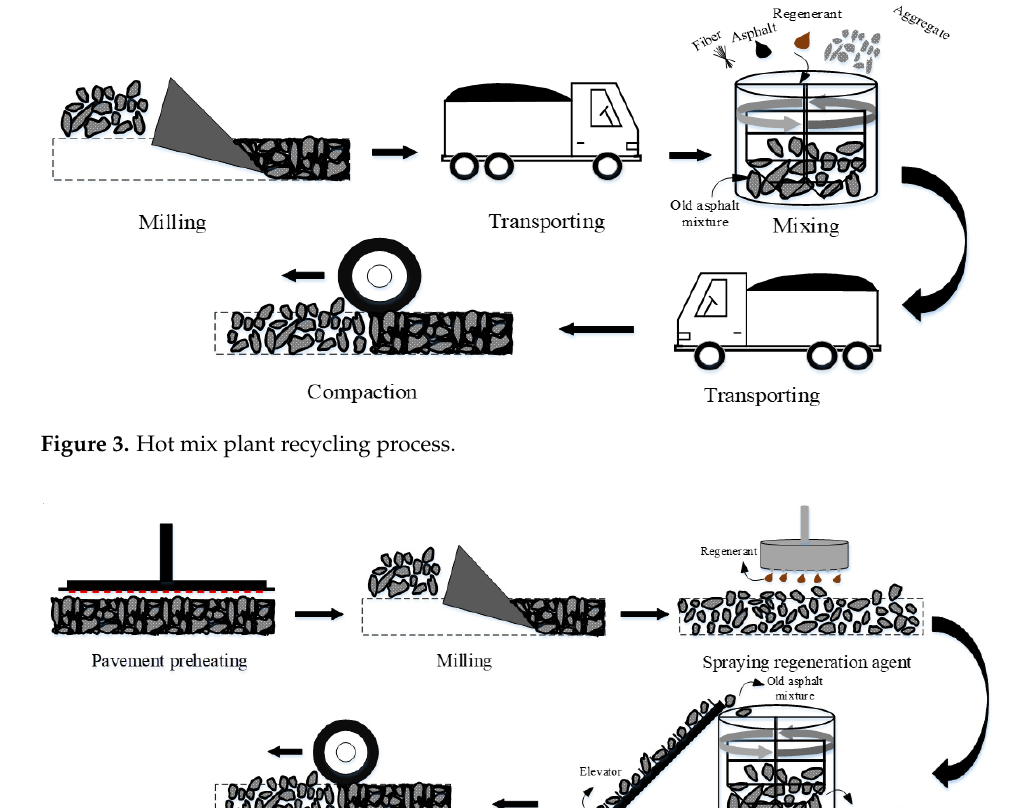
Figure 2. Milling resurfacing process.